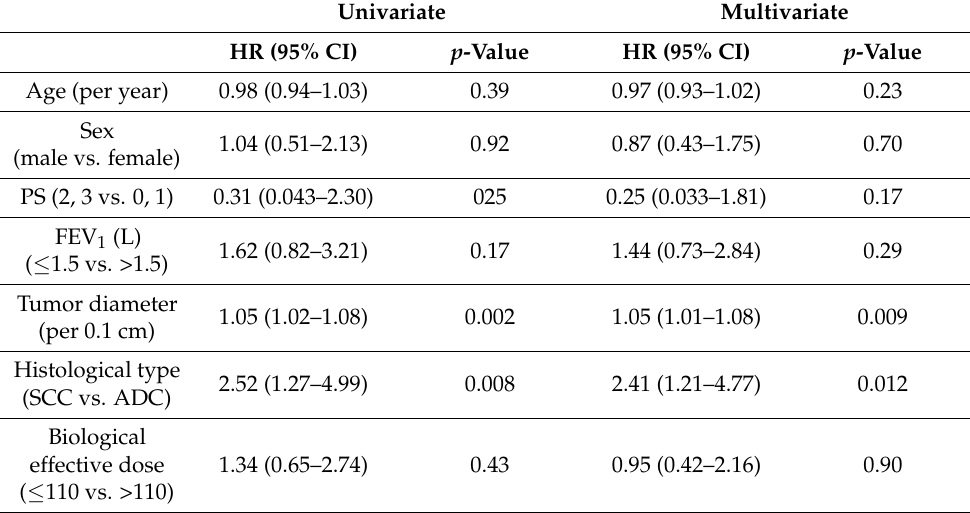
Table 3. Univariate and multivariate analyses of local recurrence. Univariate